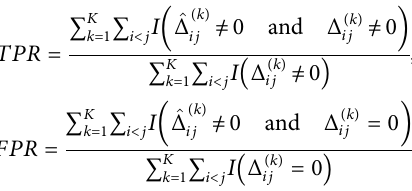
of this fi gure show the results with different values of missing rate τ . In this fi gure, each plot shows the TPR − FPR curves of various methods. Within each plot, different colored lines present the performances of different methods and different points in each line indicate the results with respect to different values of hyper- parameters. The colored lines for D-trace and WJSDM indicate their results as the values of λ varied. The colored lines for FGL, GGL, TDJGL and WDNE are obtained by fi xing the value of λ 2 (or ω 2 for GGL) and varying the values of λ 1 (or ω 1 for GGL). For ω λ 1 and 1 , we choose 15 values ranging from 0.01 to 10 (for WDNE, the value of λ 1 is ranging from 0.01 to 100).